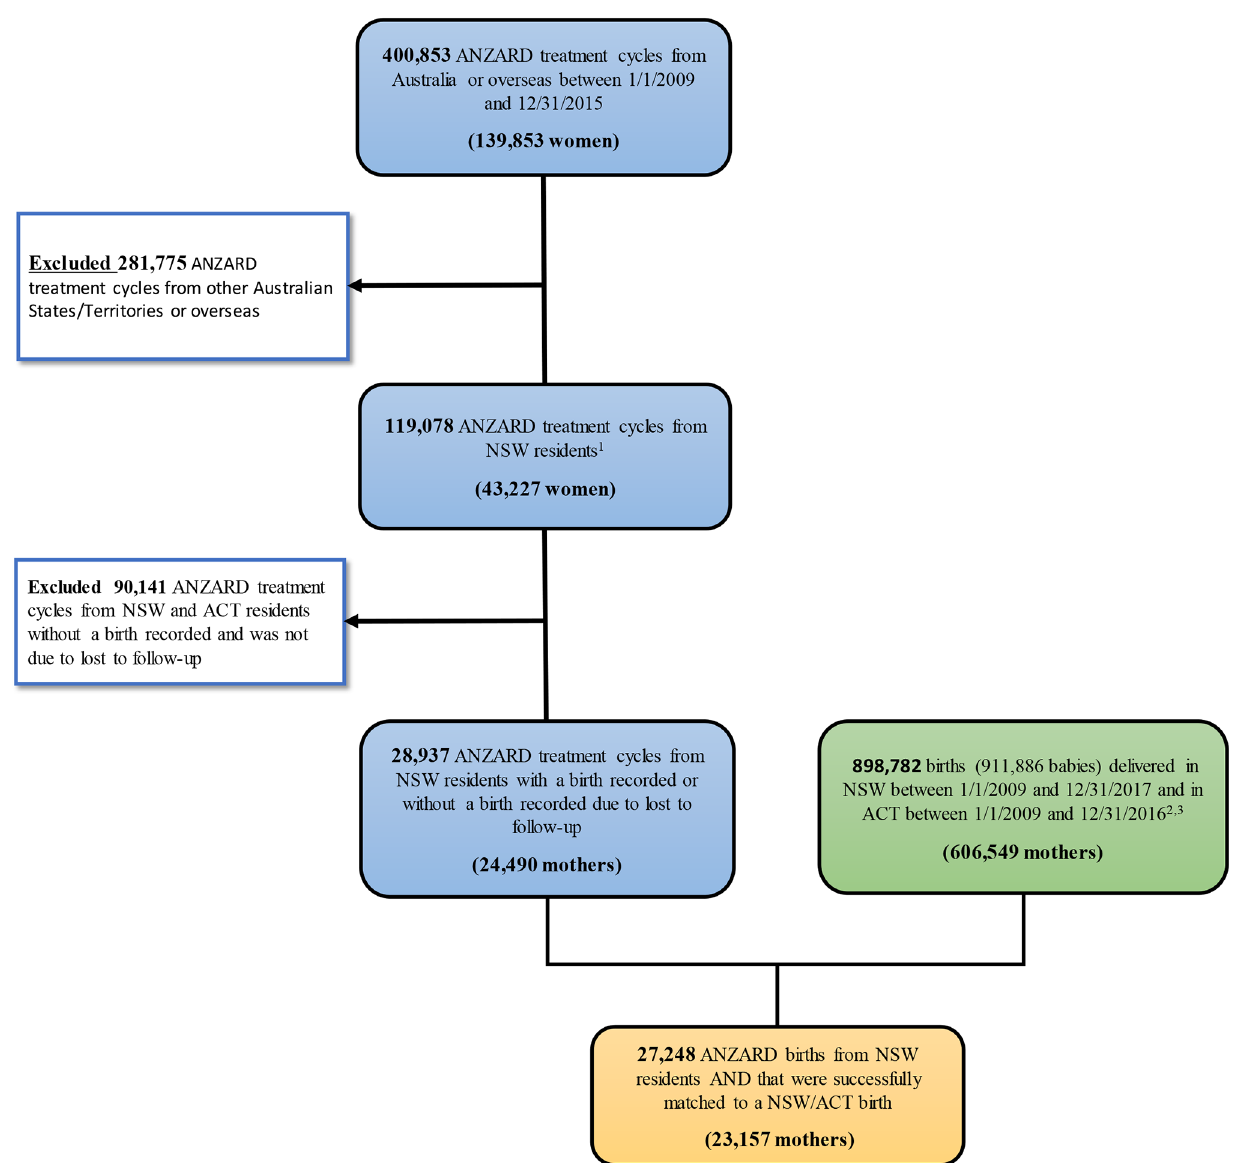
Figure 2: Flowchart for concordance analysis between ANZARD births and PDC births, for New South Wales (NSW) 1 residents, with ART/DI treatment cycles between 2009 and